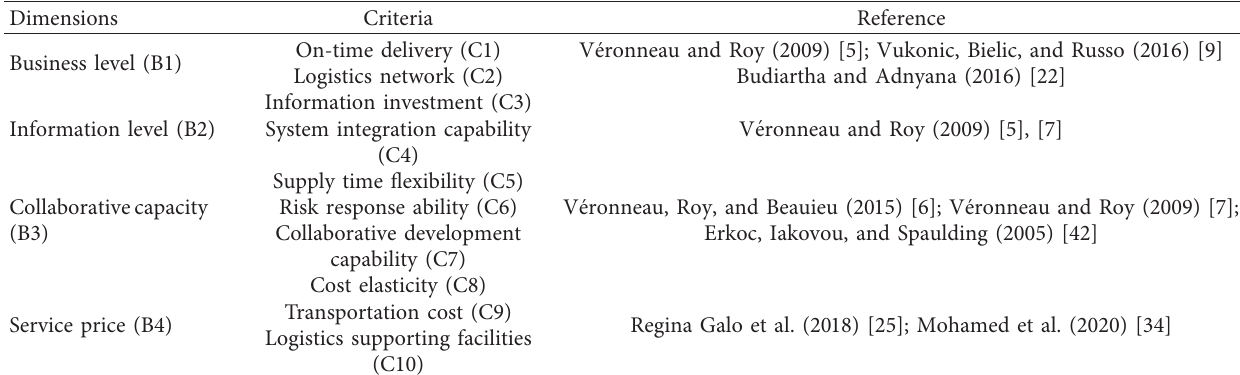
Table 2: Dimensions and subcriteria for cruise ship